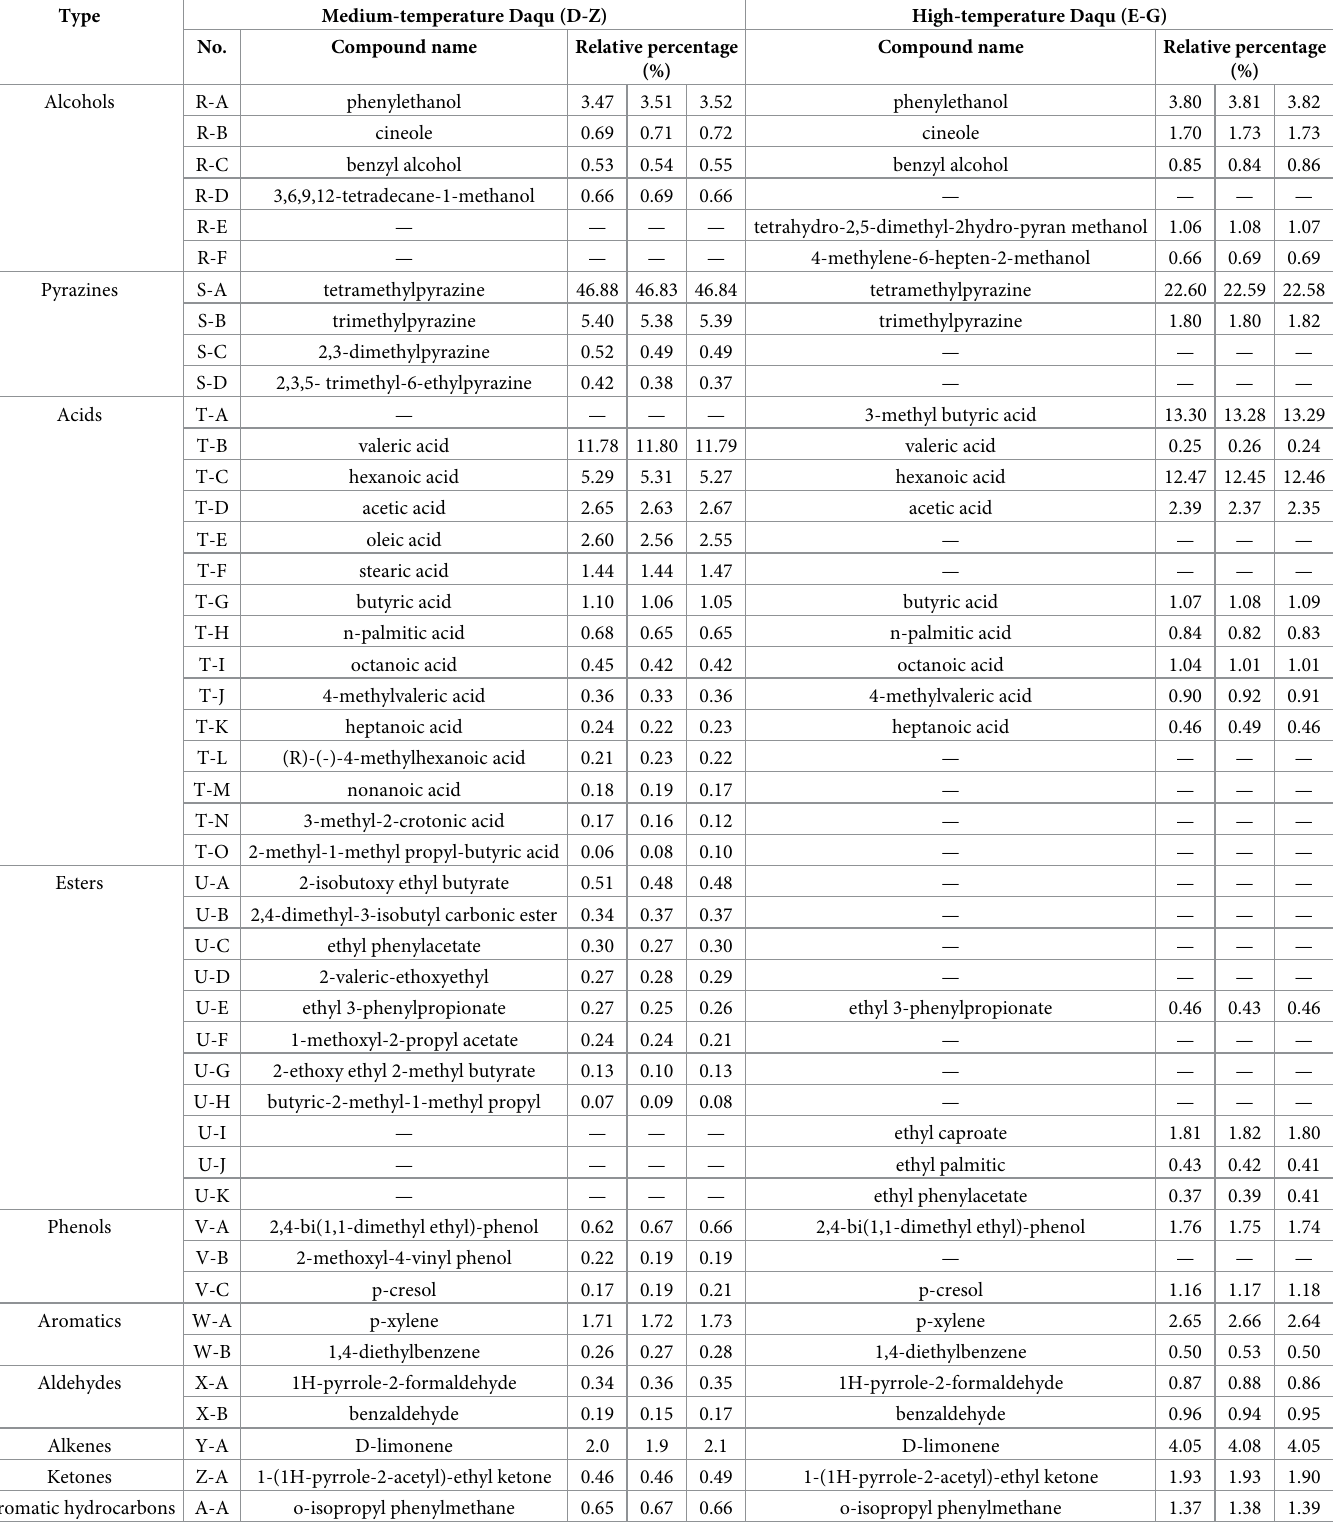
Table 3. Fragrance